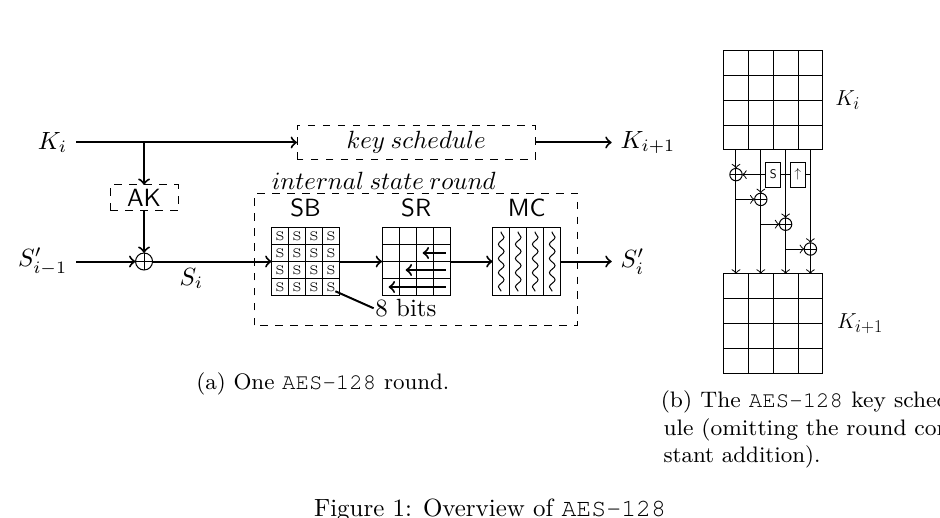
Figure 1: Overview of AES-128